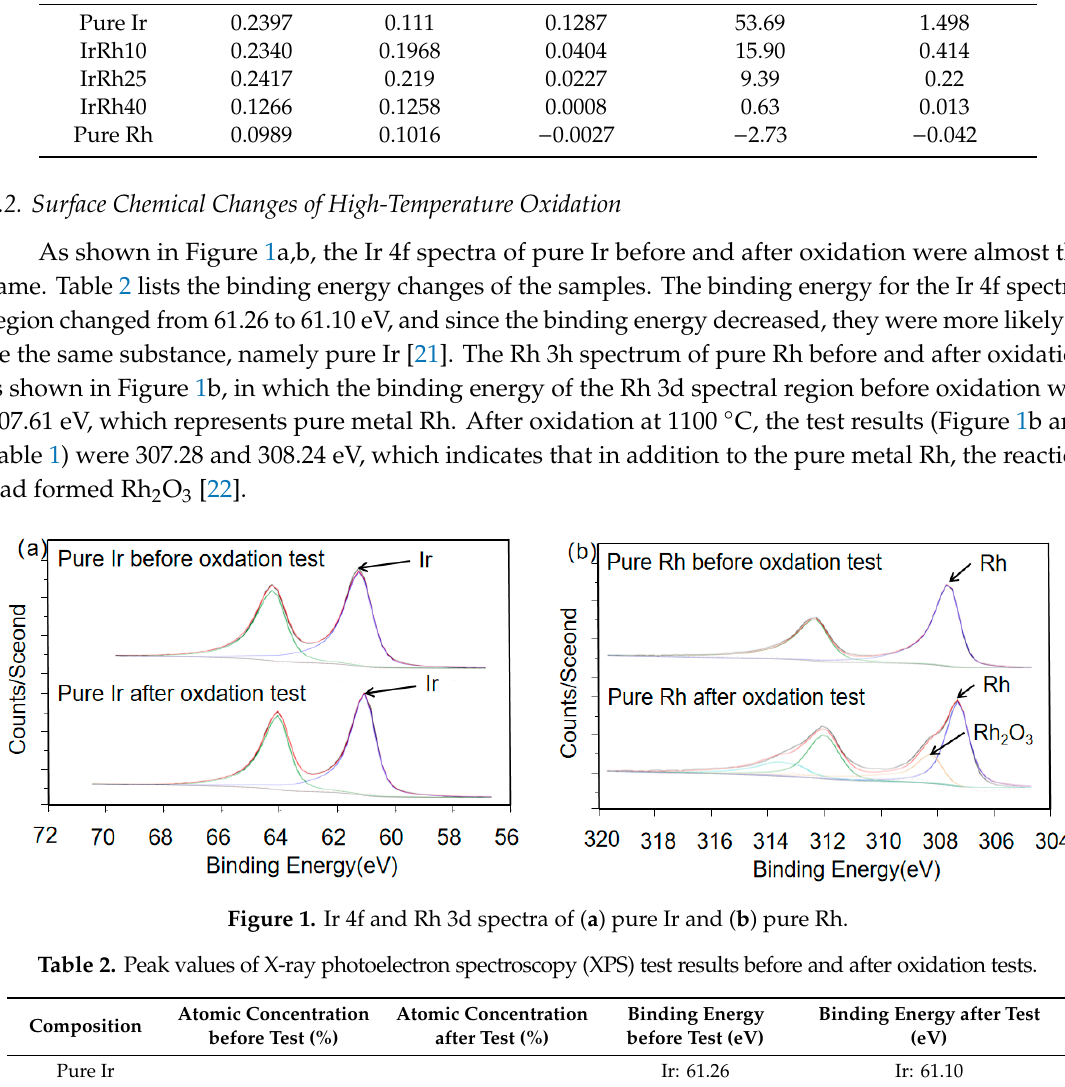
Table 1. Mass change of pure elements for 60 h under 1100 °C oxidation.